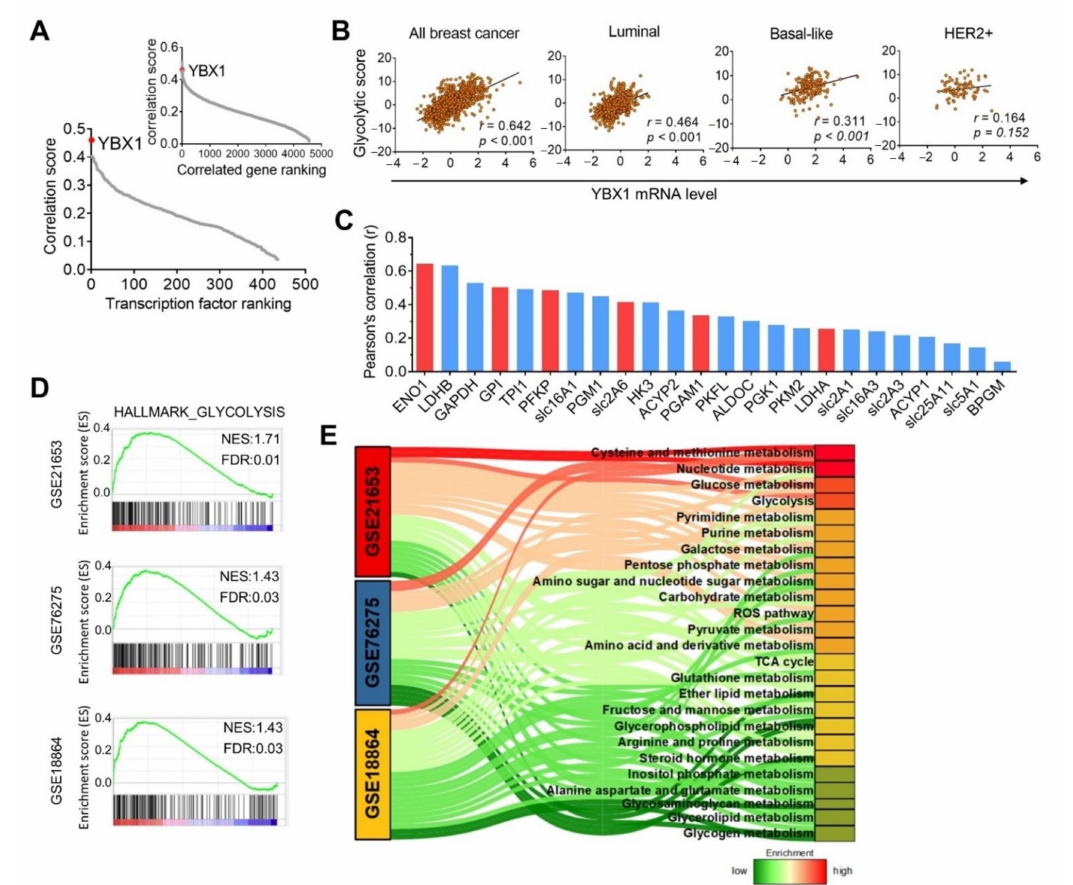
Figure 3. YBX1 is correlated with the glycolysis signature in triple-negative breast cancer. ( A ) Ranked abundance plots of transcription factors and transcripts (insert plot) with the glycolysis signature according to TCGA_BRCA dataset. ( B ) Scatterplot of Pearson’s correlation analysis of YBX1 and the glycolysis signature using TCGA_BRCA dataset. ( C ) Positive correlations of YBX1 and glycolysis-related genes, as analyzed by Pearson’s correlations. Red colors de- note the glycolytic signature. ( D ) Representative GSEA plots showing the association between YBX1 expression and glycolysis in the GSE18864, GSE21653, and GSE76275 datasets. ( E ) Sankey diagram showing enrichment of YBX1 with metabolic processes in the GSE18864, GSE21653, and GSE76275